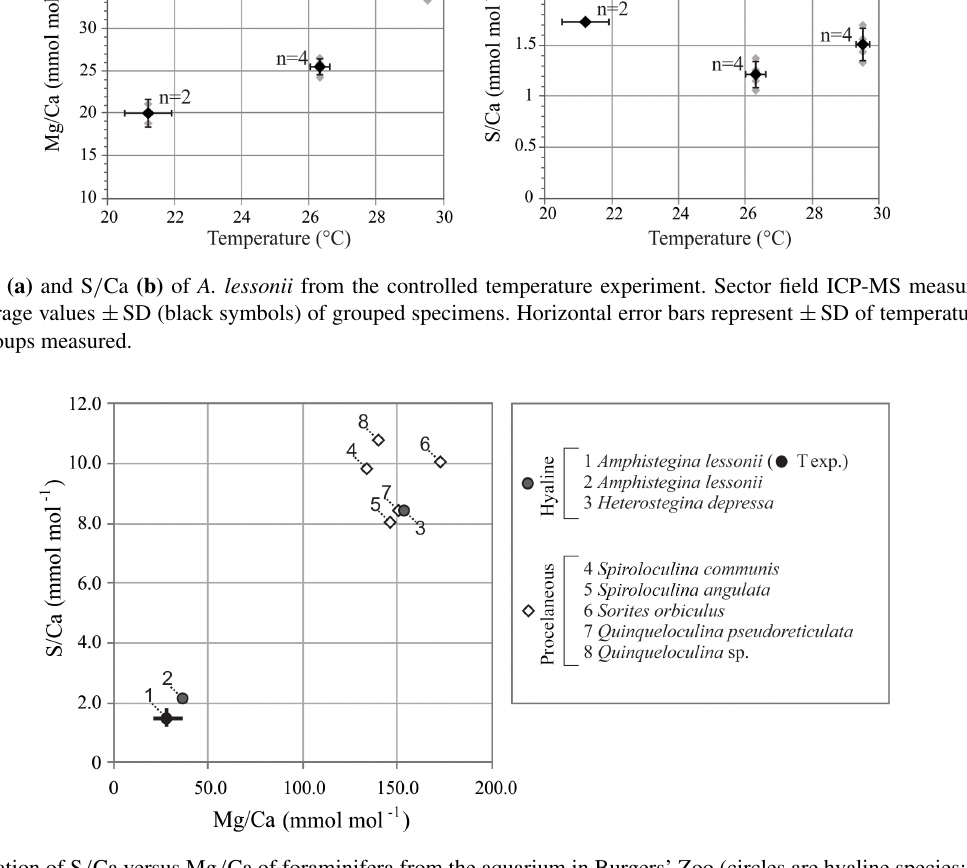
Figure 4. Compilation of S / Ca versus Mg / Ca of foraminifera from the aquarium in Burgers’ Zoo (circles are hyaline species; diamonds are porcelaneous species). Average values of the foraminifera from the temperature-controlled experiment are given in black, with maximum and minimum ranges. Numbers indicate